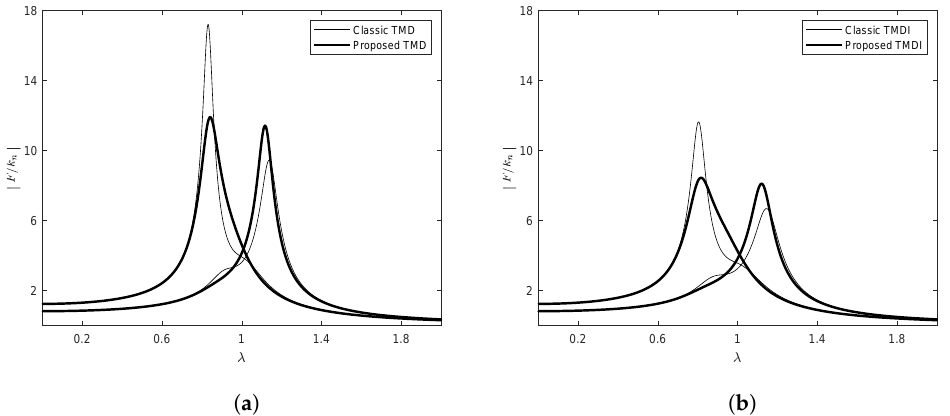
Figure 9. Frequency responses of an uncertain primary system controlled by means of ( a ) a TMD and ( b ) a TMDI. The set of parameters used for the simulation was µ = 0.05, ν = 0.03, and β = 20%. Thin solid lines: using the classic equal-peak design; thick solid lines: using the proposed design (parameters given in Tables 1 and 2). Table 3. Worst-case H ∞ norm of normalized vibration amplitude for an uncertain primary system controlled by means of either a TMD or a TMDI with the classic or proposed design. The set of parameters used for the simulation was µ = 0.05, ν = 0.03, and β = 20%. Classic